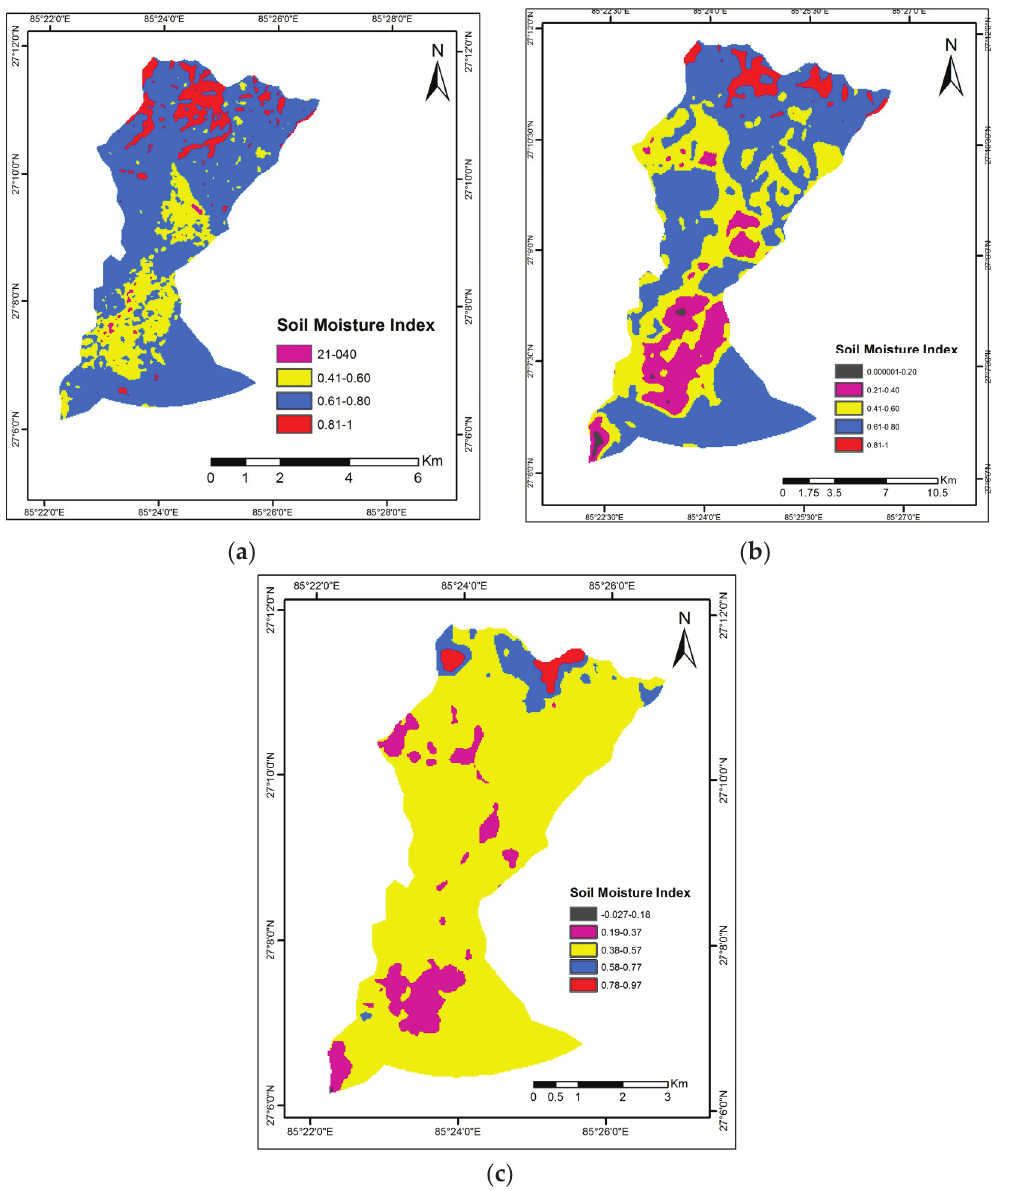
Figure 5. Soil moisture index of Judibela VDC for different years: ( a ) 2000; ( b ) 2014; and ( c ) 2015. Table 6. Soil moisture index (SMI) for the different years in Judibela VDC.